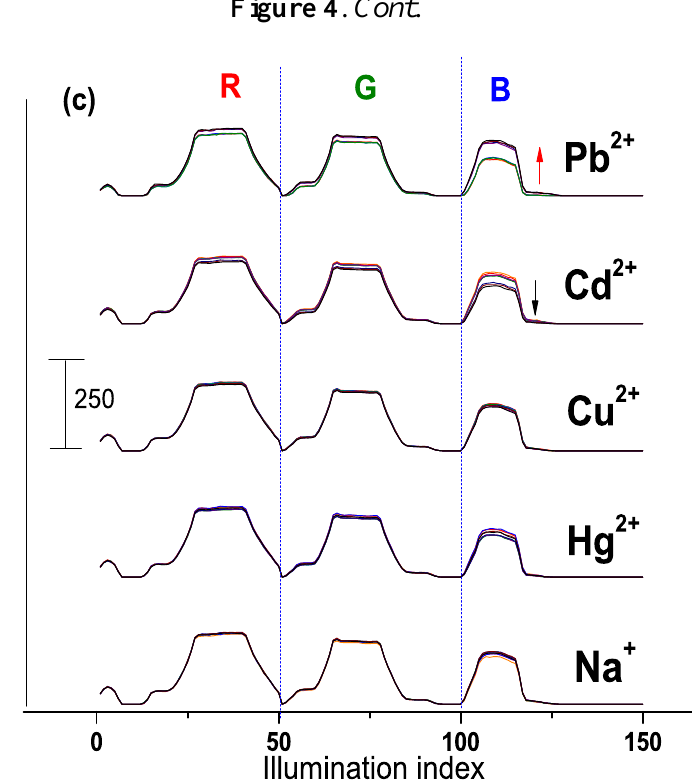
Figure 5. PCA analysis of metal ions with opto-potentiometric Mb1 – Mb3 based on H